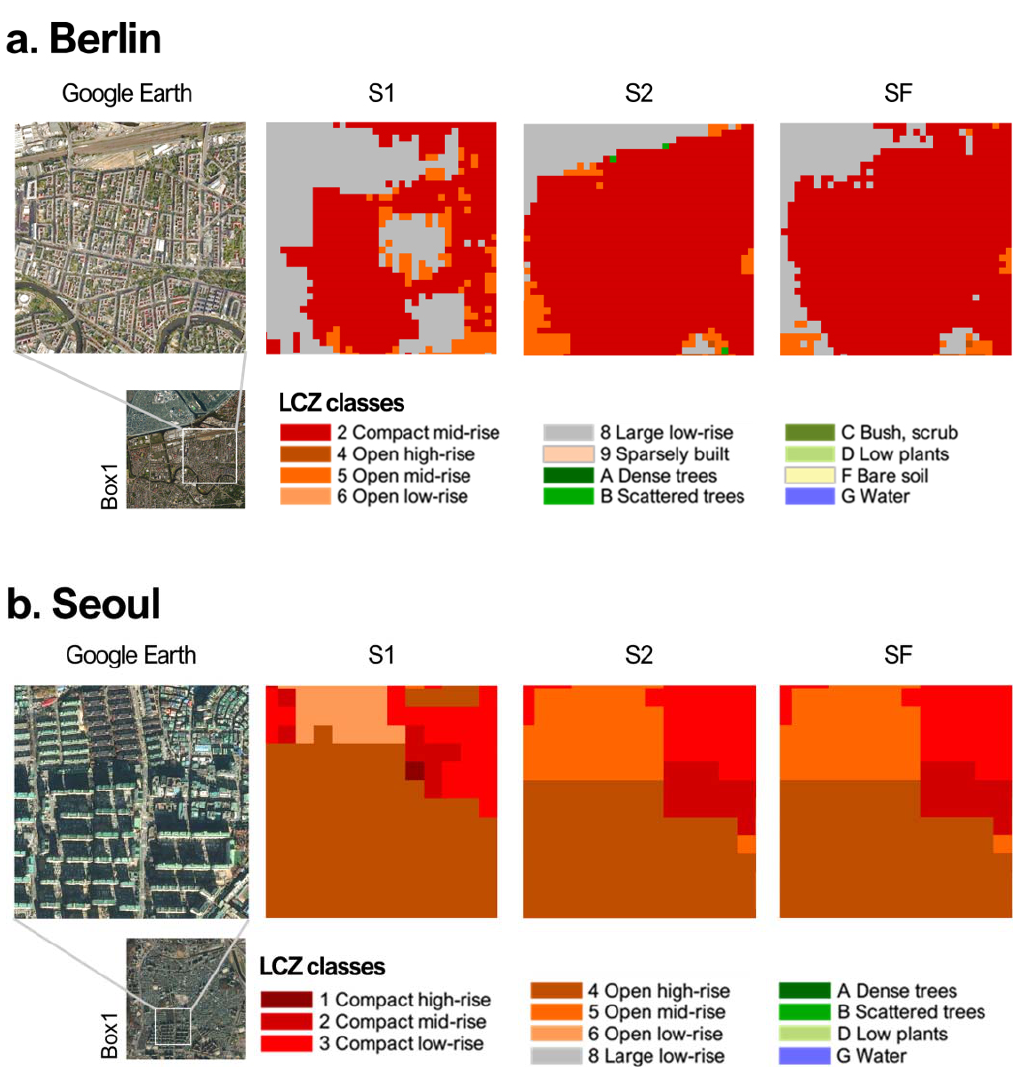
Figure 9. Detailed comparison of S1, S2, and SF in the first subset domain (Box 1) in Figure 8 for Berlin ( a ) and Seoul ( b ). Google Earth images of each region are also presented. Table 5. The area ratio of each LCZ class to the total area on the maps of S1, S2, and SF for both Berlin and Seoul.